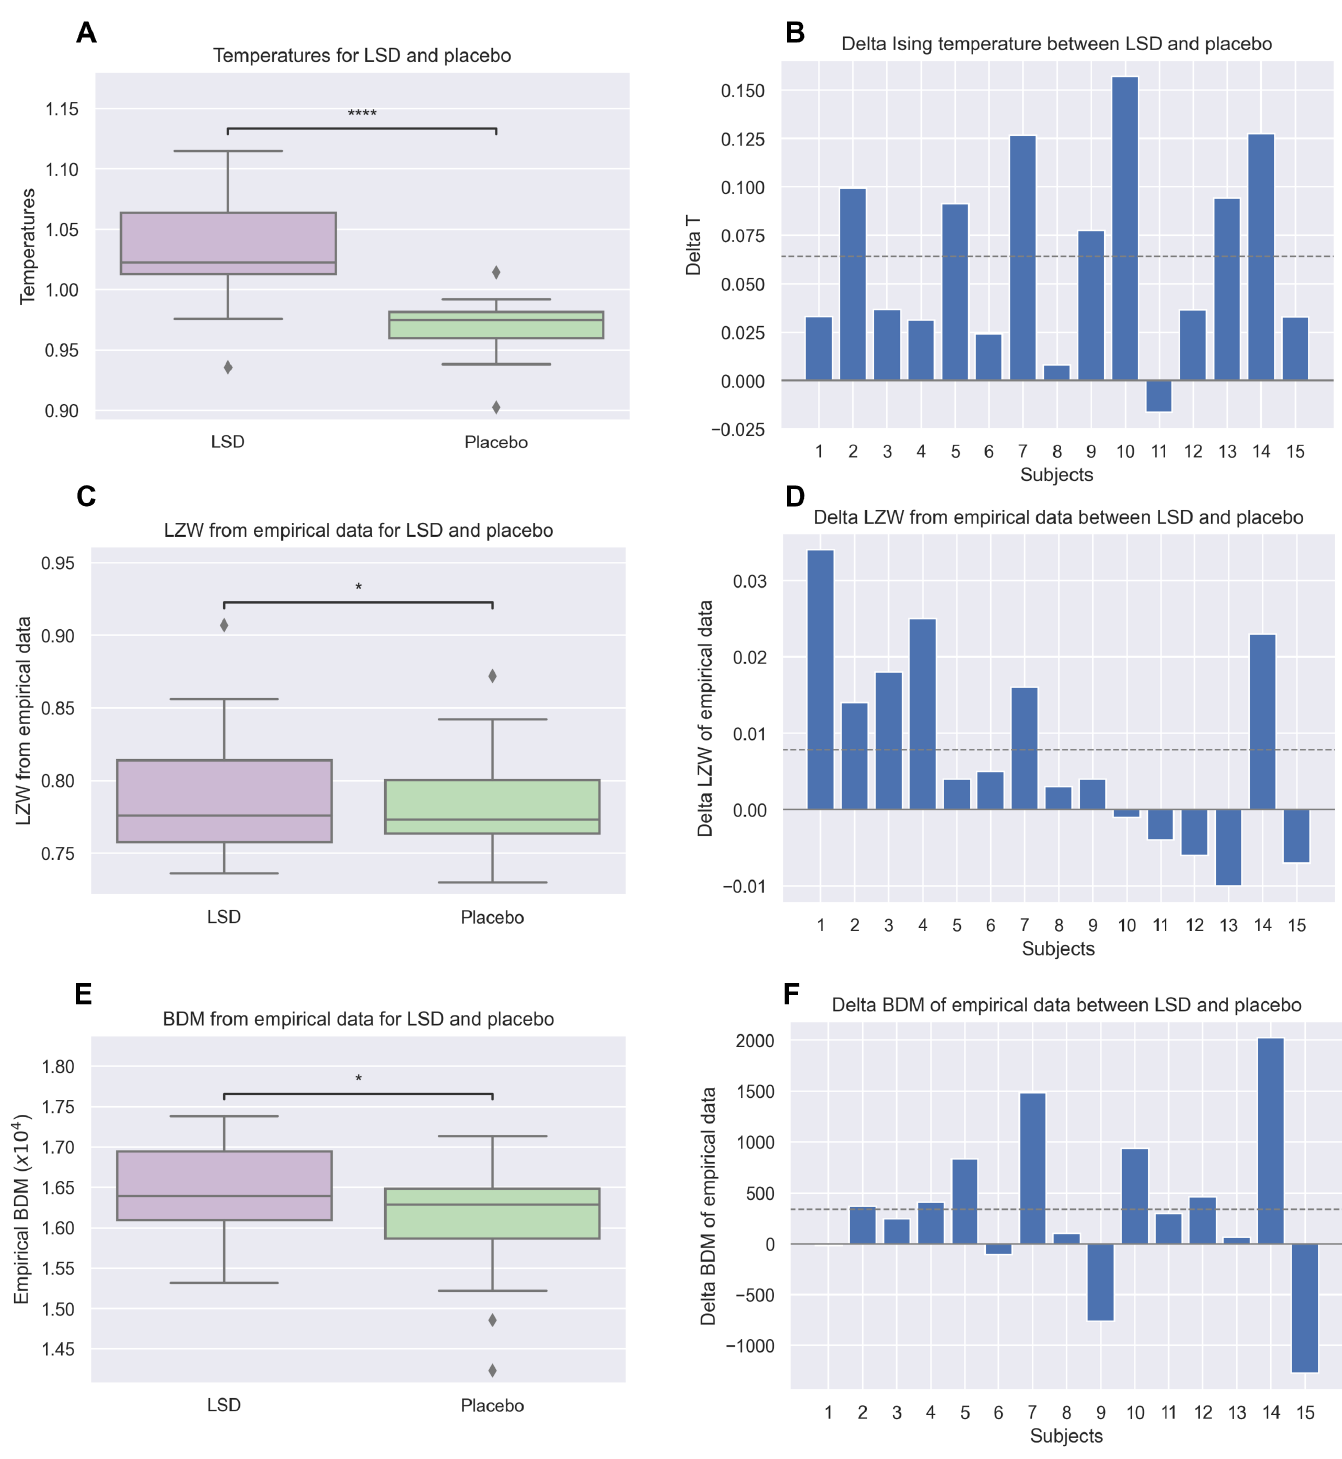
Fig 4. Individual shift of Ising temperature (top), LZW (middle), and BDM (bottom) complexity induced by LSD (empirical data). The LZW and BDM estimates here are computed from the experimental fMRI BOLD data times series. A, C, E) Box plots of the metrics (temperature, LZW and BDM complexities) for each subject under the effect of LSD and placebo (one star: p < 0.05, four stars: p < 0.0001). B, D, F) Bar plots of the differences in metric (temperature, LZW and BDM complexities) between LSD and placebo for each subject. The dashed line in each plot represents the mean of the metric.